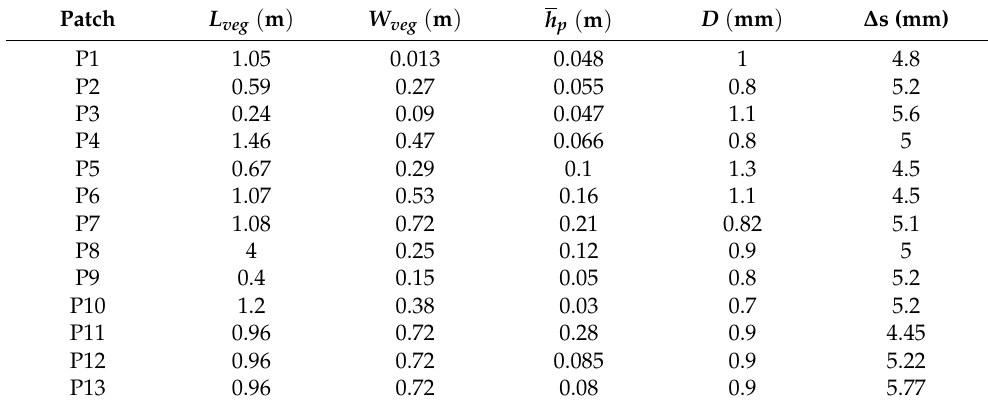
Table 1. Geometric properties of vegetation